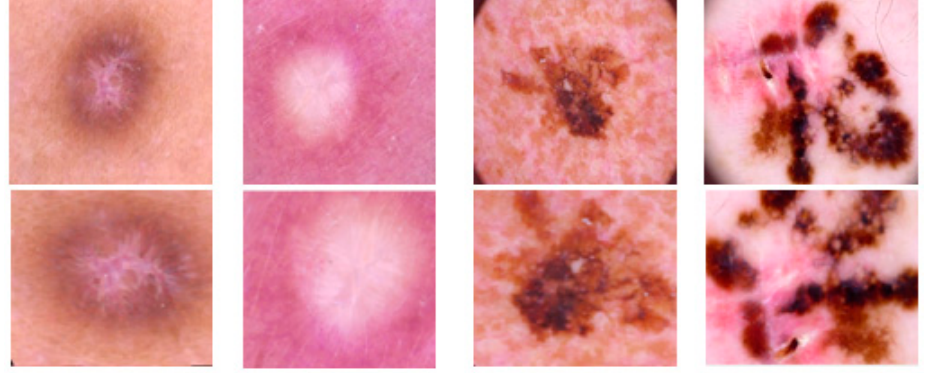
Figure 2. Examples of applied data augmentation .